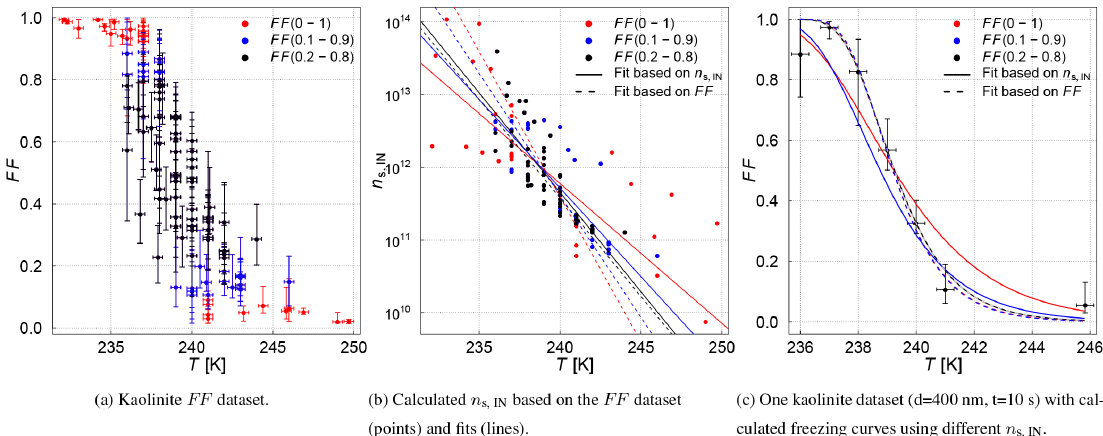
Figure D2. Sensitivity study of different methods to estimate the surface site density n s , IN of kaolinite and the resulting freezing curve. The data subsets are color coded as indicated in the